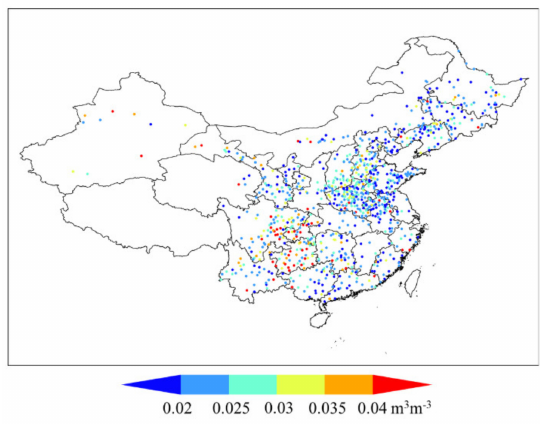
Figure 11. Distribution map for RMSE of in situ sites obtained via TC-based validation. Red dots represent large